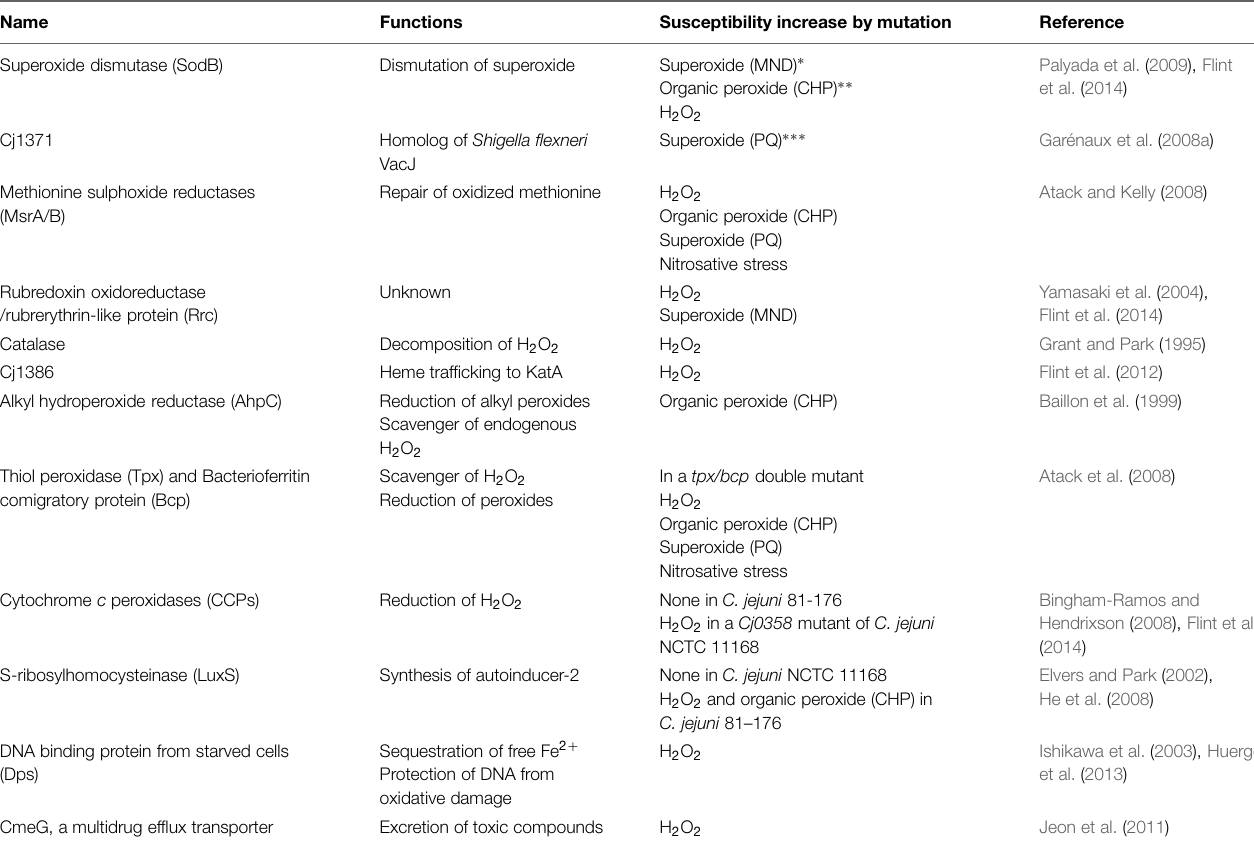
TABLE 1 | Proteins associated with oxidative stress defense in C.